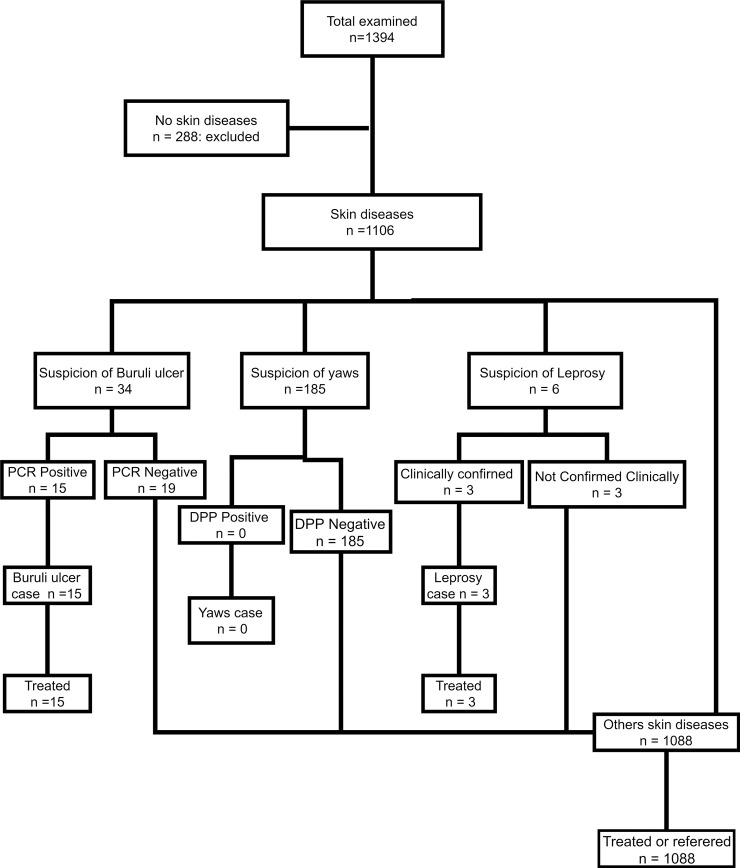
Flow-chart of cases.